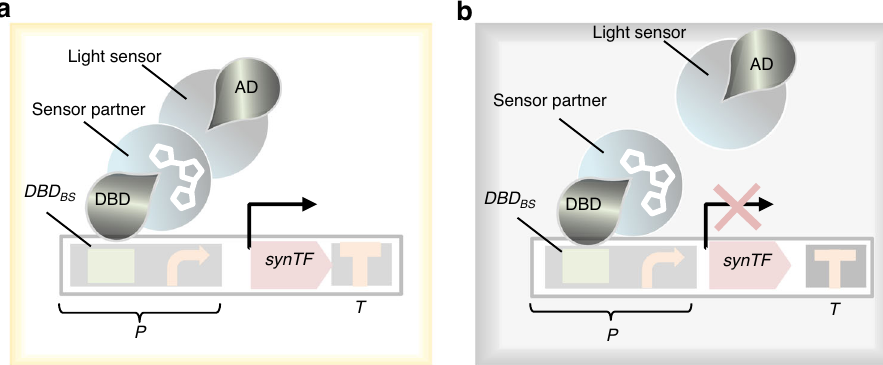
Fig. 5 | Light-dependent expression system. a Light triggers the dimerization of thelight-sensingdomainanditspartner,thusleadingtothejoiningofDBDandAD to form a functional synthetic activator. Next, the synthetic activator targets its BS within a promoter, thus resulting in the expression of a synTF. b In the absence of